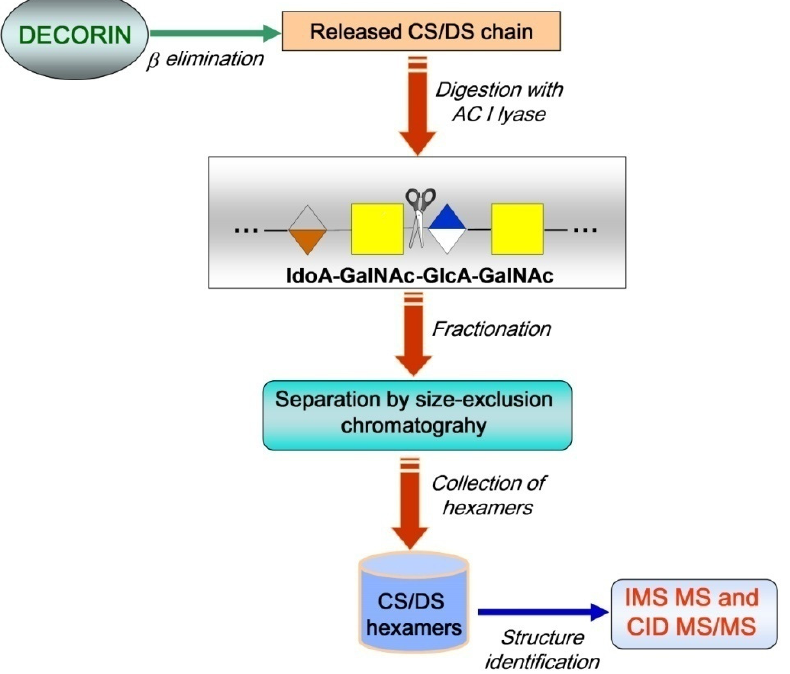
Figure 1. Schematic of the general workflow for CS/DS chain releasing, depolymerization by chondroitin AC I lyase, separation, collection, and analysis by IMS MS and CID MS/MS of hexasaccharide CS/DS domains in human DCN.